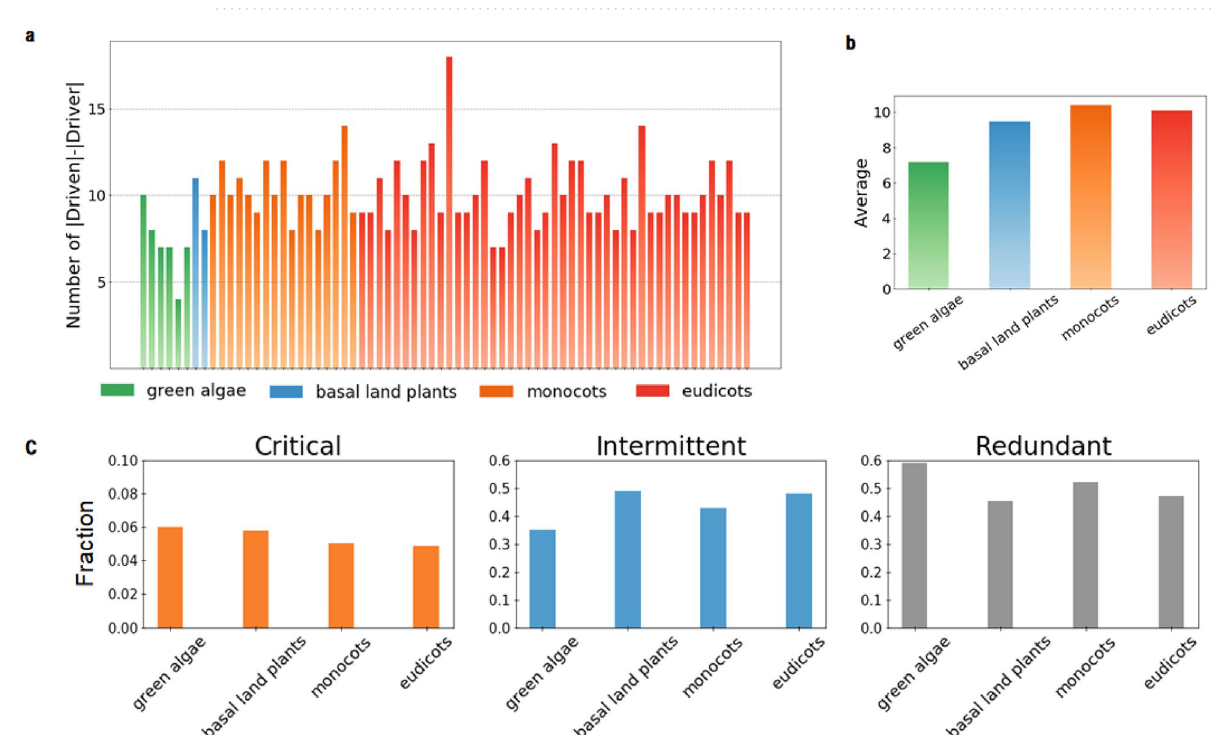
Figure 4. ( a ) The histogram for each plant species of the difference between number of |driven|–|driver| nodes in each plant lineage and ( b ) its average per plant lineage. The average value tends to increase with evolutionary time. ( c ) The fraction of critical, intermittent and redundant driven nodes for each major plant